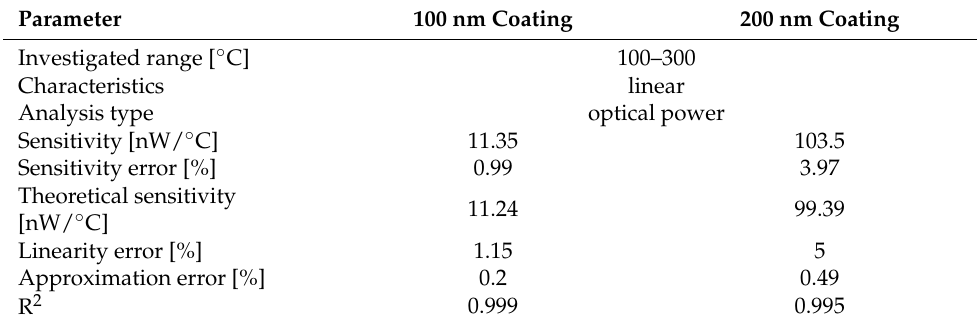
Figure 9. The dependency of the peak optical power on the temperature: ( a ) comparison of the obtained peak optical power of the reflected signal for each sensor, ( b ) obtained data and linear approximation. Table 2. List of metrological parameters of the microsphere-based fiber-optic temperature sensors— optical power analysis.